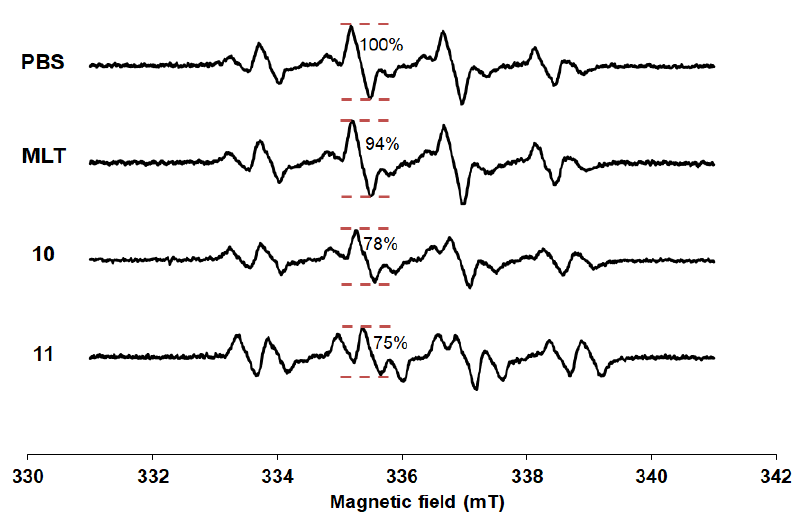
Figure 3. ESR spectra of spin adduct of hydroxyl radical observed in Fenton reaction.